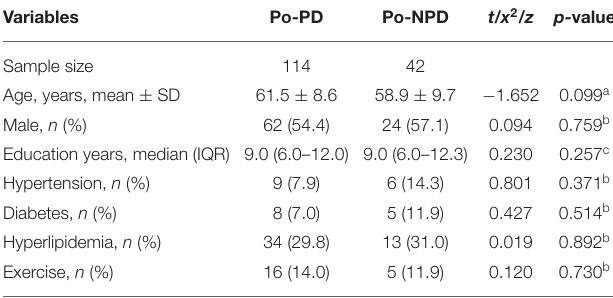
TABLE 2 | Baseline data after 1-year